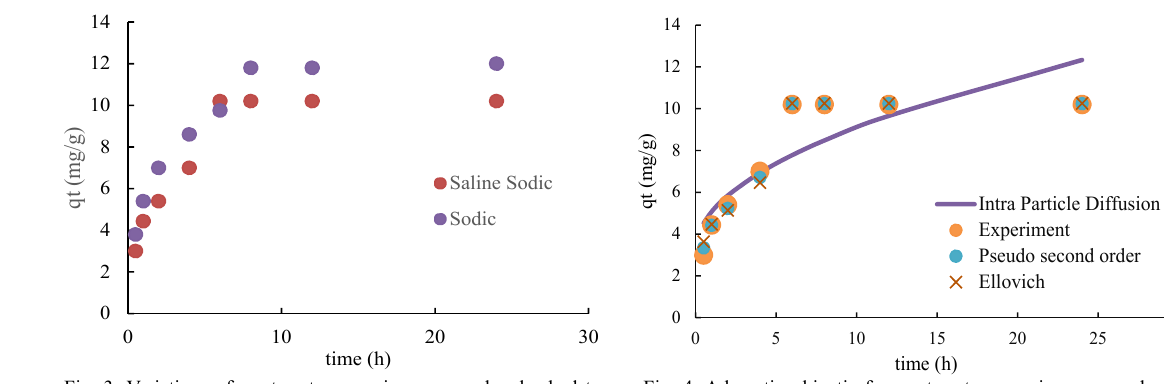
Fig. 3: Variations of wastewater organic compounds adsorbed to soil (q t ) over time Fig. 4: Adsorption kinetic for wastewater organic compounds on saline-sodic